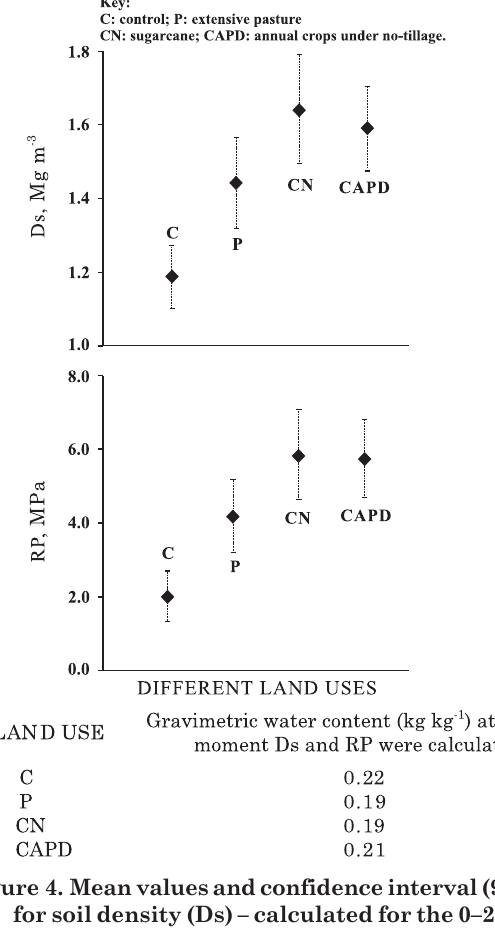
Figure 4. Mean values and confidence interval (95 %) for soil density (Ds) – calculated for the 0–20 cm soil layer – and soil penetration resistance (PR) – calculated for the 0–40 cm soil layer – in areas of different land